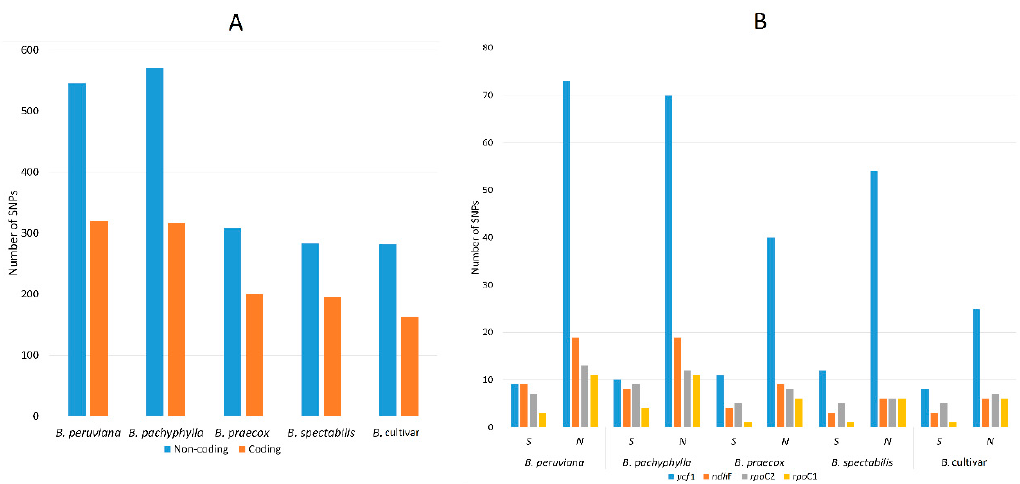
Figure 8. Summary of SNPs detected in the five Bougainvillea chloroplast genomes. ( A ) Frequency of SNPs in the coding and non-coding regions. ( B ) Protein-coding genes with highest numbers of synonymous and non-synonymous SNPs.